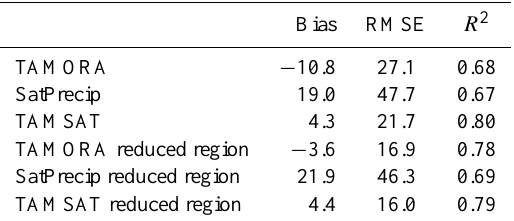
Table 2. Summary statistics for evaluation of TAMORA, SatPre- cip and TAMSAT against kriged gauge data over the Sahel at 0.5 ◦ , 10 day scale. Reduced region estimates are only evaluated over the Sahel sub-region where 2004 JAS gauge rainfall is ≤